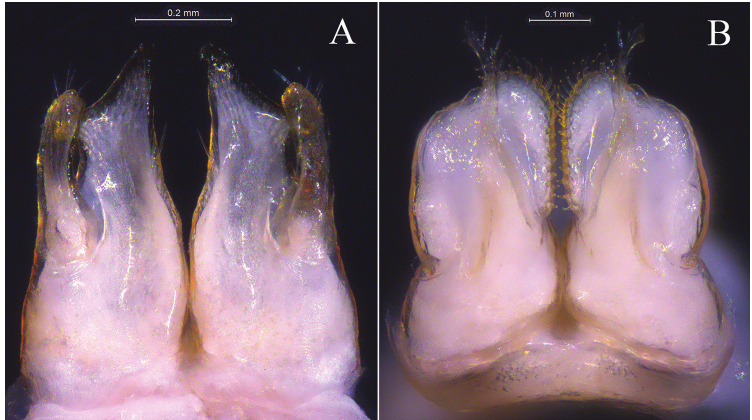
Figure 4. Glyphiulus foetidus sp. n., holotype. A anterior gonopods, caudal view B posterior gonopods, caudal view.